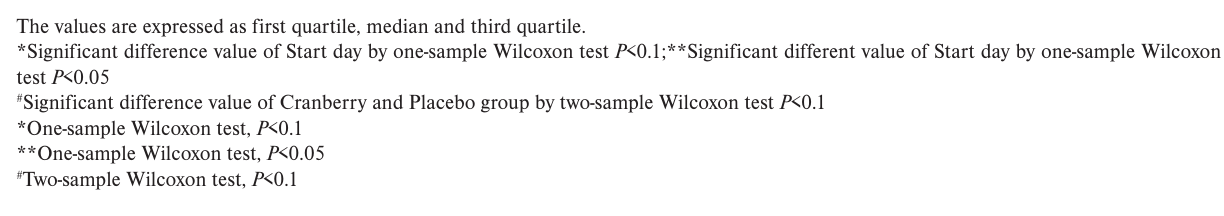
Table 7. Specific markers in ex vivo prostate